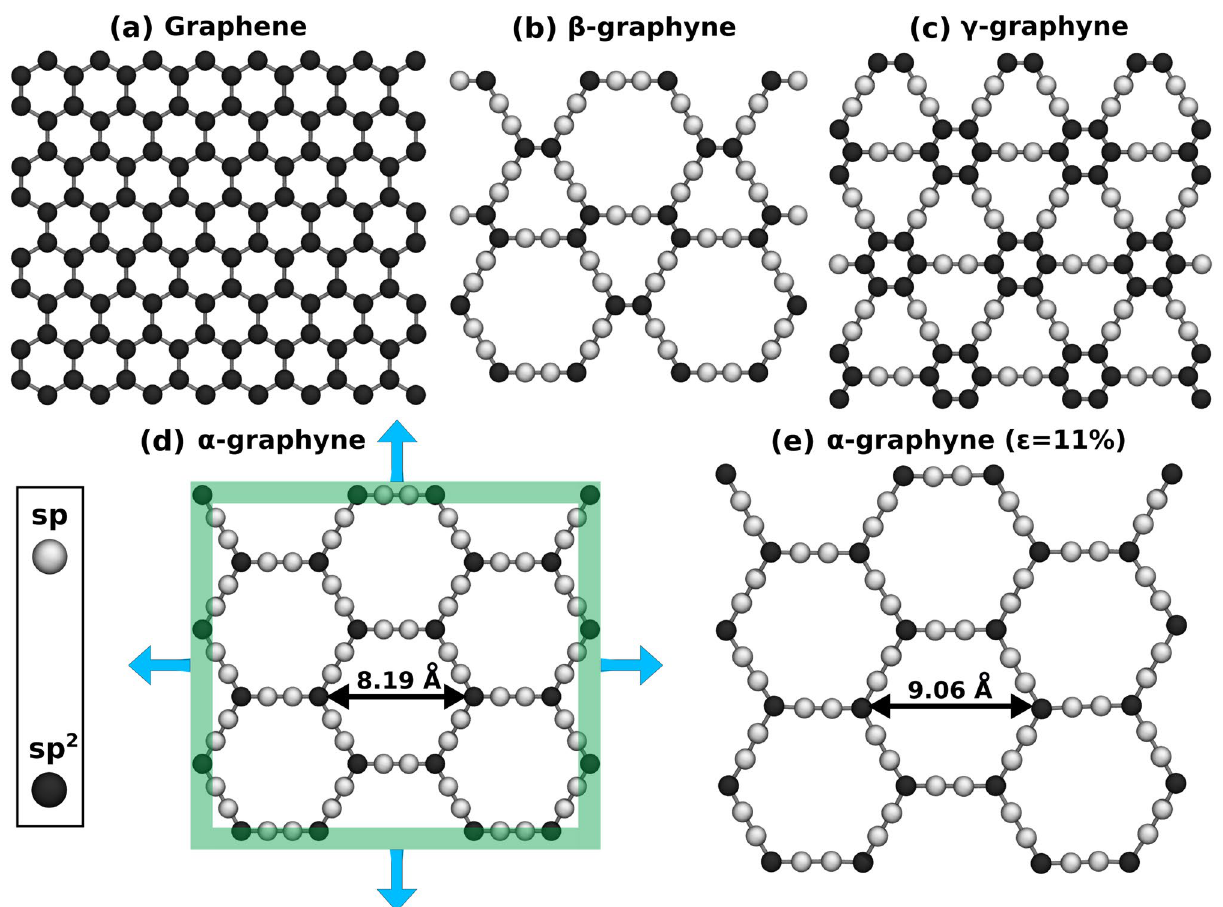
Figure 1. ( a – d ) Investigated structures. We deform both planar directions equally in this work, as indicated in ( d ). ( e ) presents the α -graphyne monolayer after the application of 11% biaxial strain. Sp/sp represented using white/black spheres in this